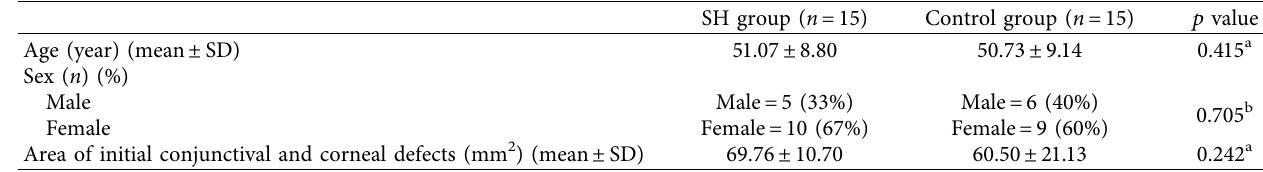
Figure 4: CONSORT flow diagram and follow-up of a randomized controlled trial of the SH group versus the control group for patients. Table 1: Demographic and baseline clinical characteristics of patients.